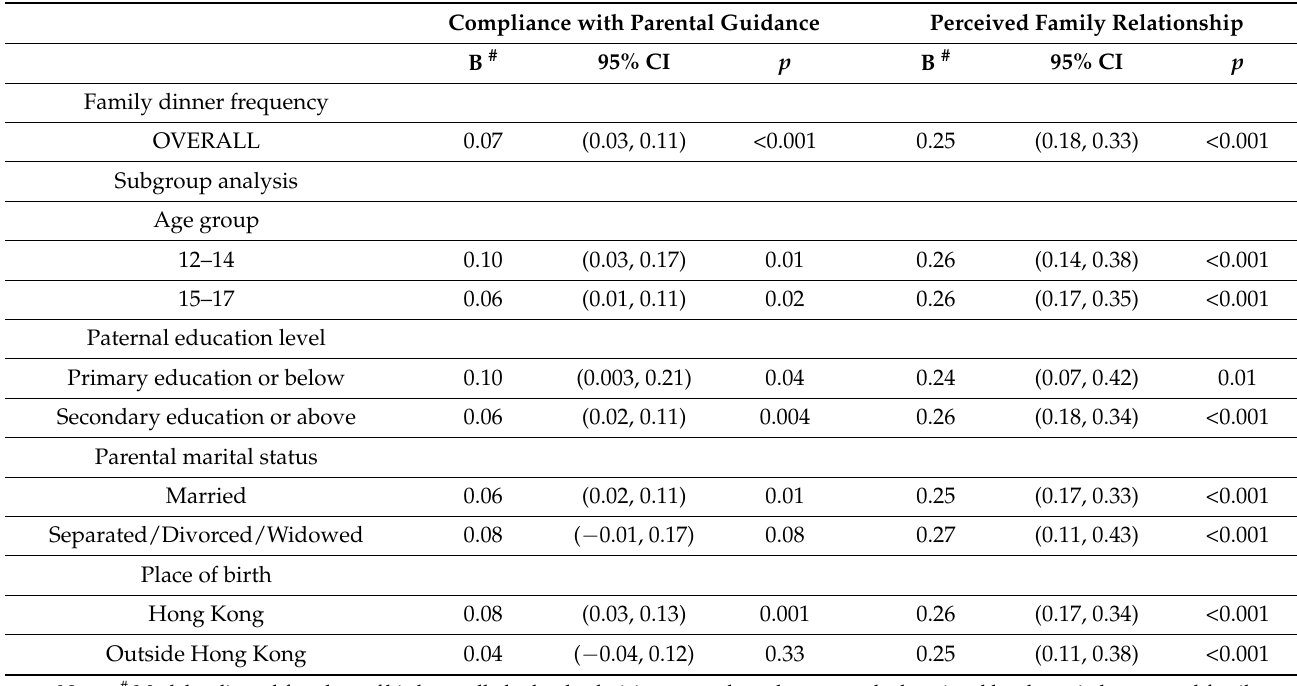
Table 4. Linear regression analyses of the association between family dinner frequency and adolescent perception of family relationship and compliance with parental guidance. Compliance with Parental Guidance Perceived Family